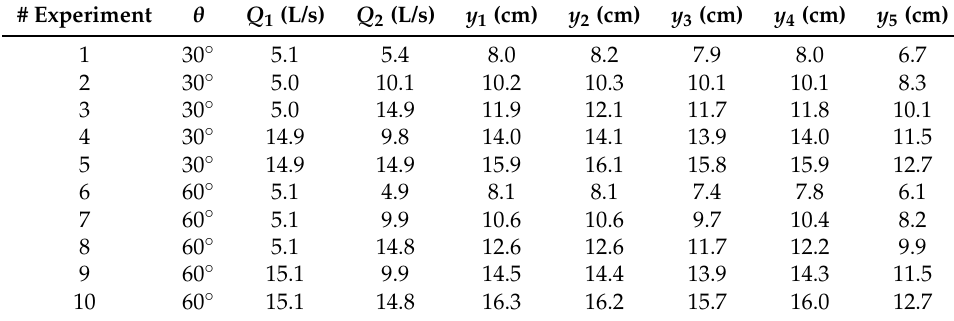
Table 1. Experimental results taken from